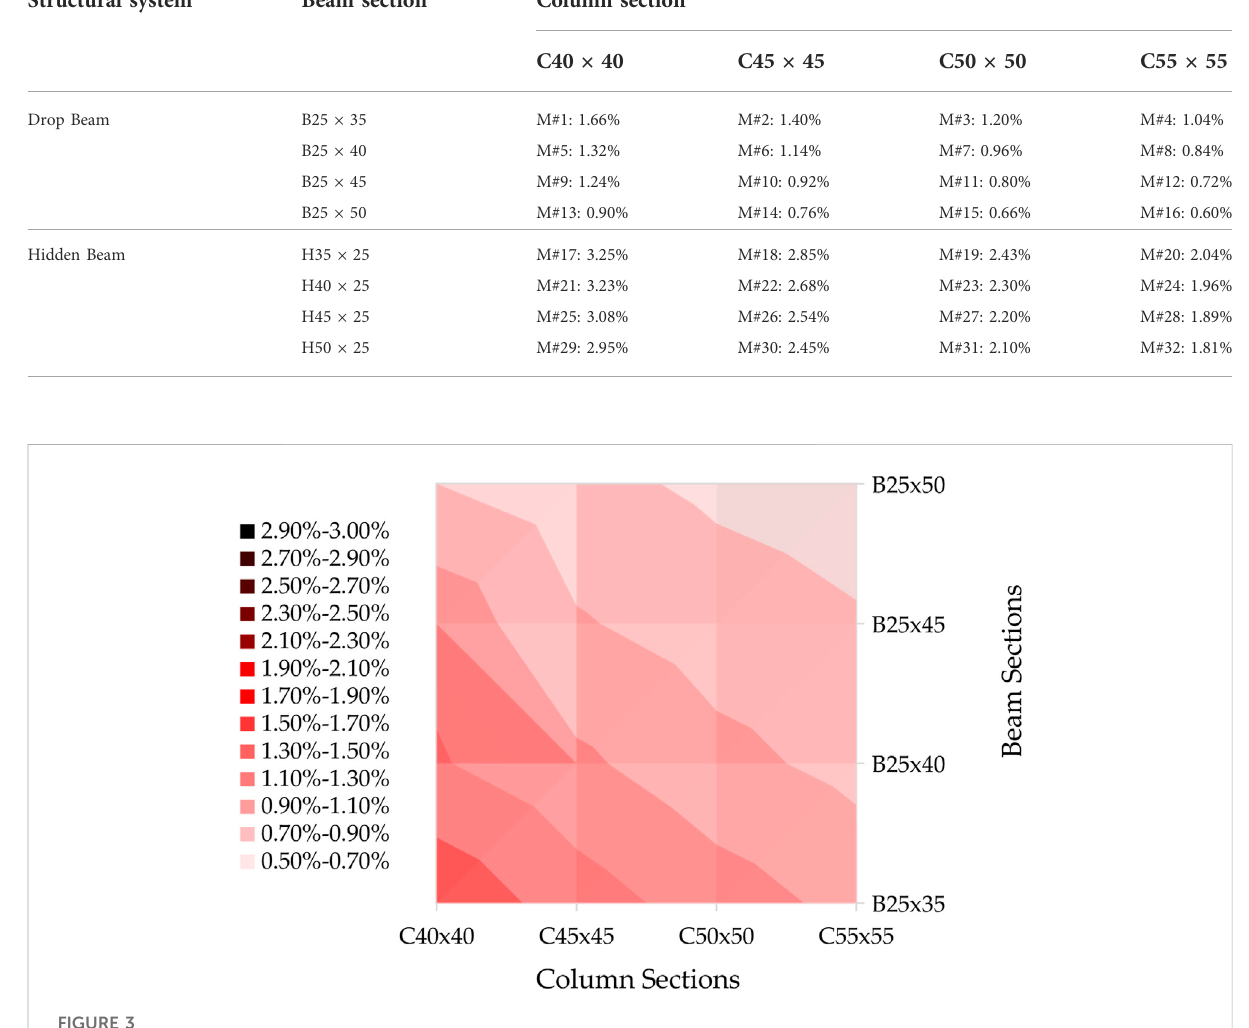
FIGURE 3 Interstory drift results of drop beam